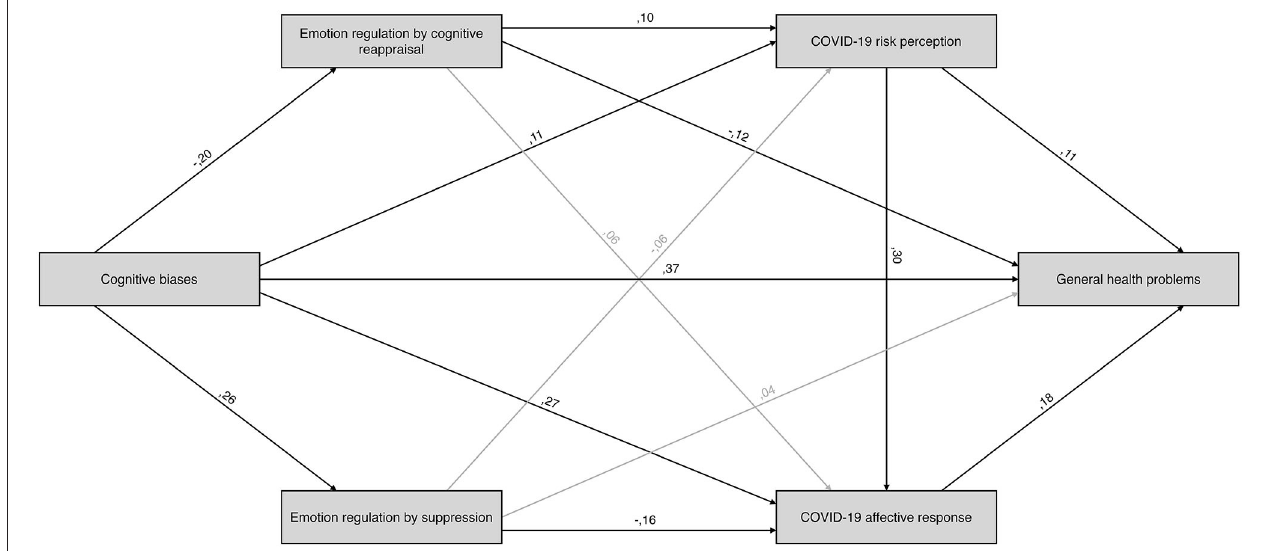
FIGURE 1 | Path model of the associations between cognitive biases, general health problems, risk perception and affective response to COVID-19. Statistically insignificant paths are displayed in